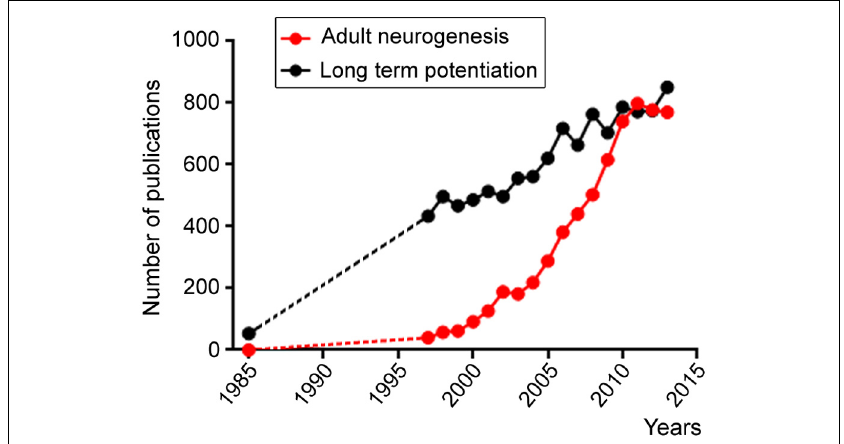
FIGURE 1 | Scattered plots illustrating the number of publications per year obtained in Pubmed using the following two key words: adult neurogenesis (red) and long term potentiation. Both fields display increases over time, but the adult neurogenesis field displays an exponential increase starting in the late 1990’s while the long term potential field displays a linear increase likely reflecting the increase in the number of scientists during this